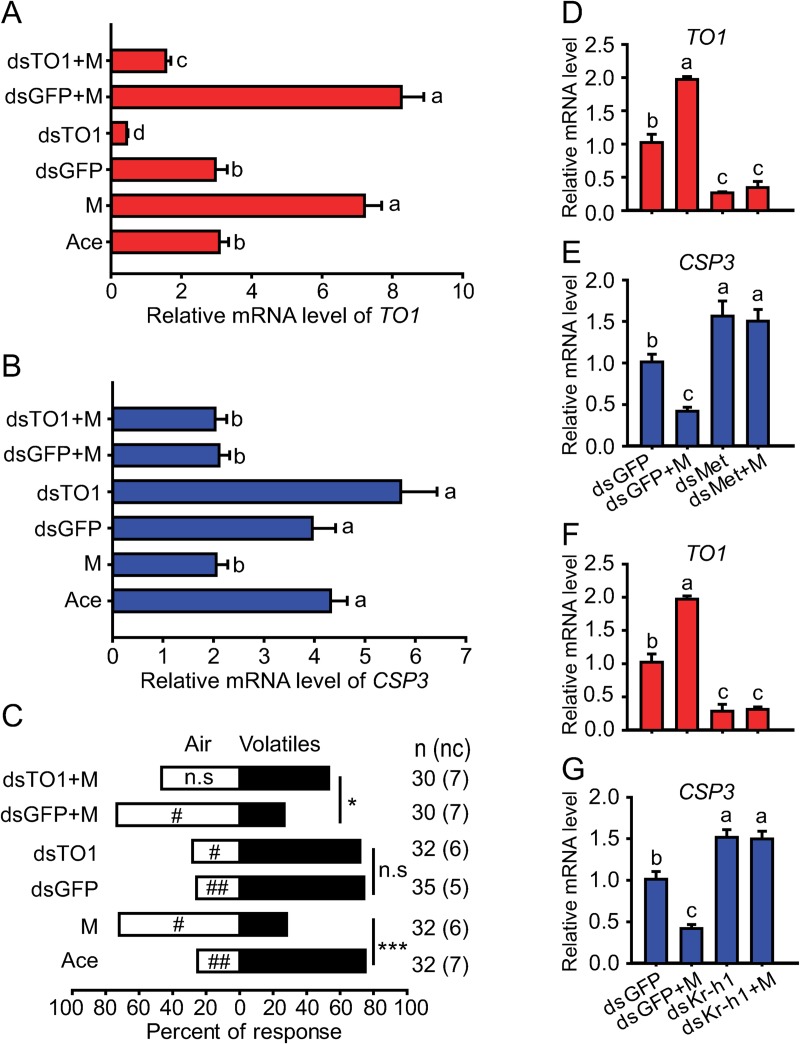
Effects of JH or JH signaling pathway genes on antennal gene expression and choice behavior in gregarious nymphs.(A) Relative mRNA level of TO1 gene after methoprene treatment or injection of dsGFP or dsTO1 combined with methoprene treatment. (B) Relative mRNA level of CSP3 gene after methoprene treatment or injection of dsGFP or dsTO1 combined with methoprene treatment. (C) Choice behavior after methoprene treatment or injection of dsGFP or dsTO1 combined with methoprene treatment. (D and E) Relative mRNA level of TO1 or CSP3 genes after injection of dsGFP or dsMet or rescued by methoprene. (F and G) Relative mRNA level of TO1 or CSP3 genes after injection of dsGFP or dsKr-h1 or rescued by methoprene. M, methoprene.